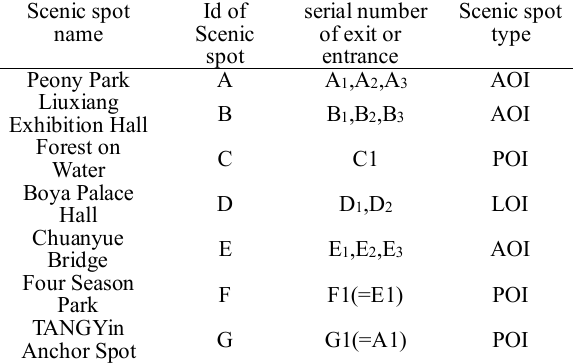
Tab2. Information of Experiment Area